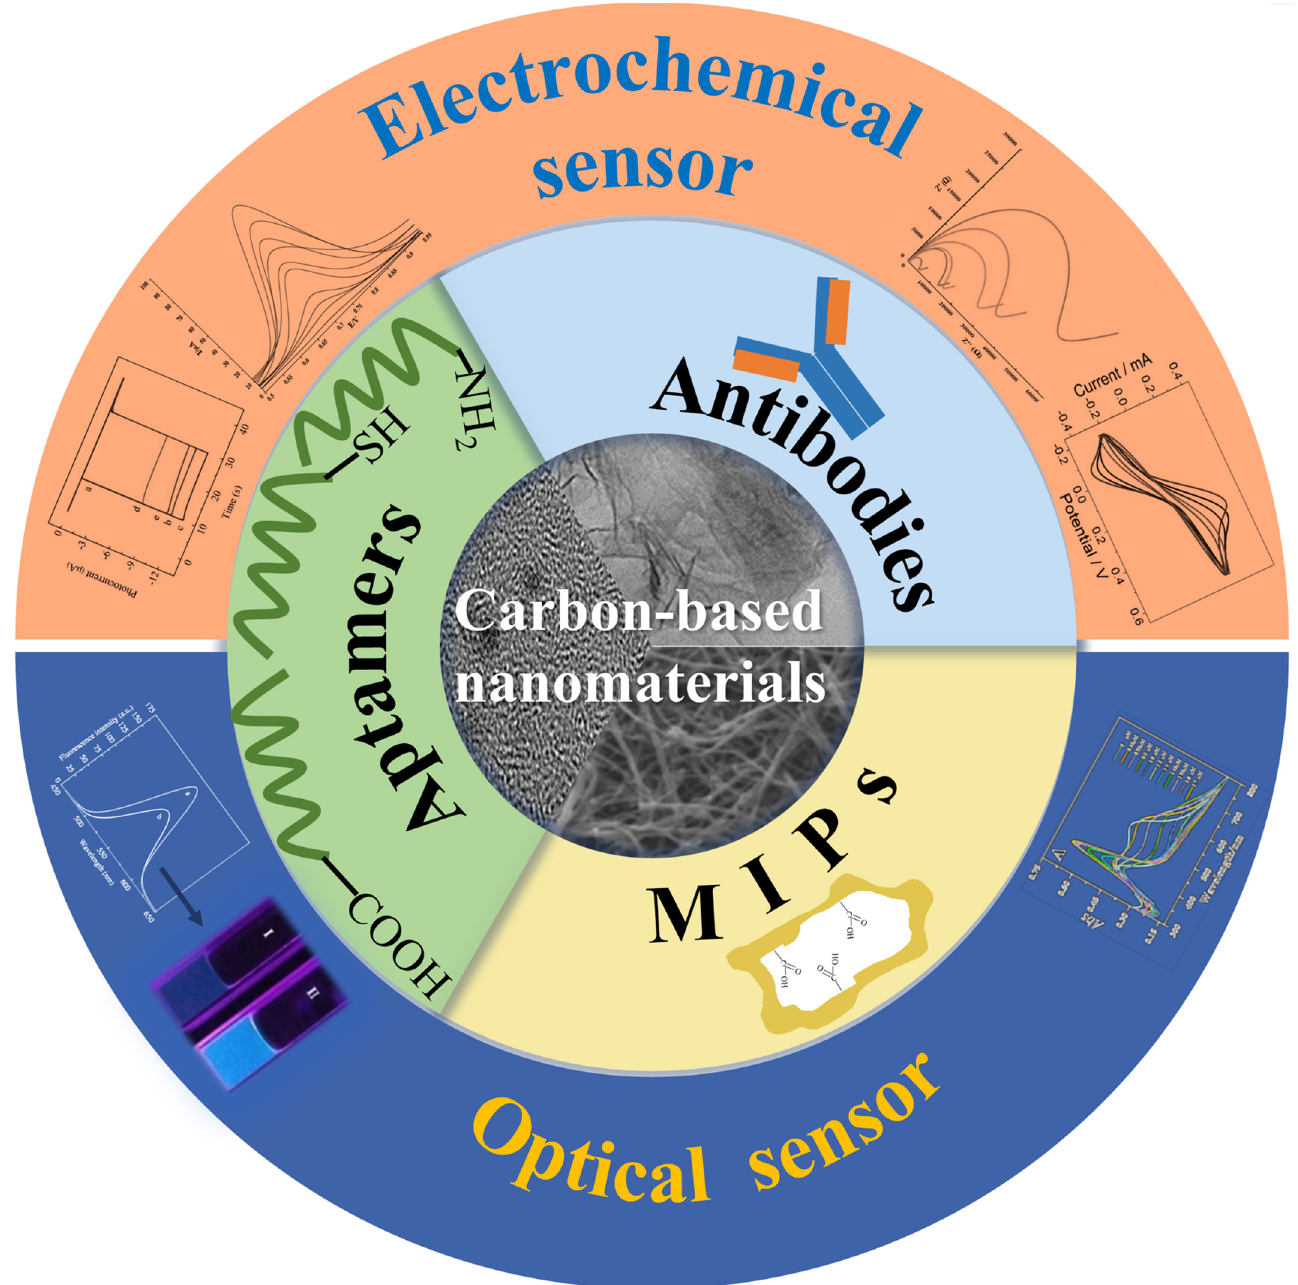
Figure 1. Functionalization of Carbon nanomaterials and its application of mycotoxins detection.